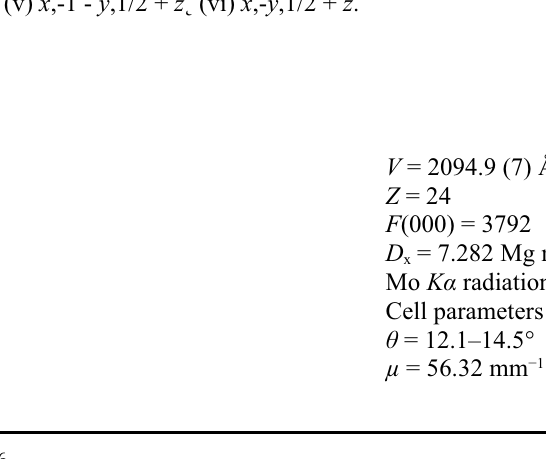
Figure 2 Coordination polyhedra of the different Pb cations. Displacement ellipsoids are drawn at the 50% probability level. The labeling scheme for symmetry-related atoms is the following: (i) 0.5 - x ,1/2 + y ,1.5 - z ˛ (ii) x ,1 + y , z ˛ (iii) - x ,- y ,1 - z ˛